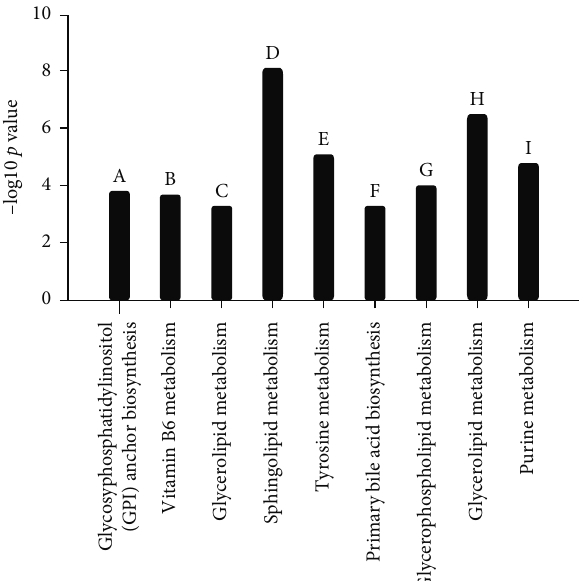
Figure 3: The extremely early altered metabolism pathway responding to TAVR. (a–d) The involved metabolism pathway based on altered metabolite from the ascending aorta; (e, f) the involved metabolism based on altered metabolite from the coronary sinus; (g–i) the involved metabolism based on an altered metabolite from the peripheral vein.